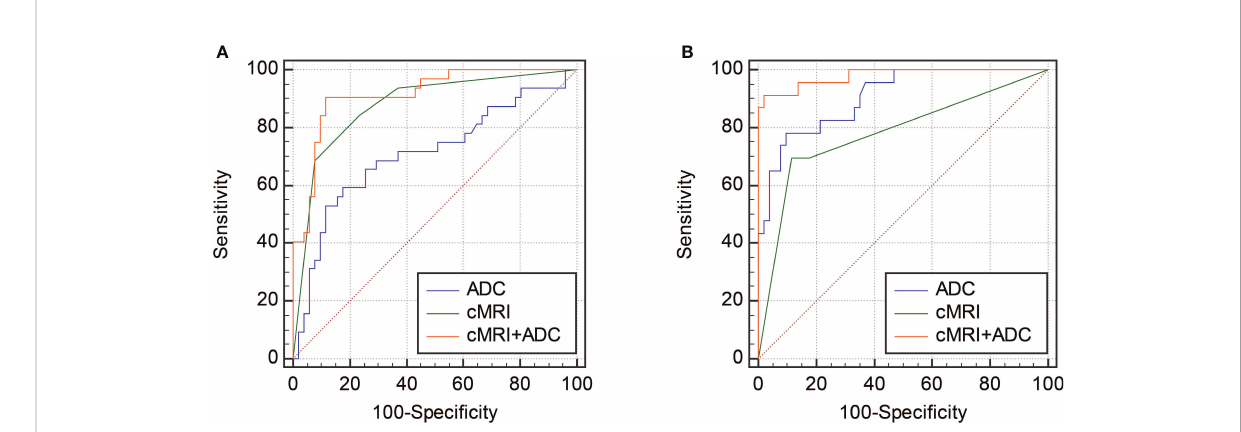
FIGURE 5 ROC curves showing the diagnostic performances of cMRI, ADC and the combination of cMRI and ADC in differentiating CLs from degenerated LMs (A) and USs (B)